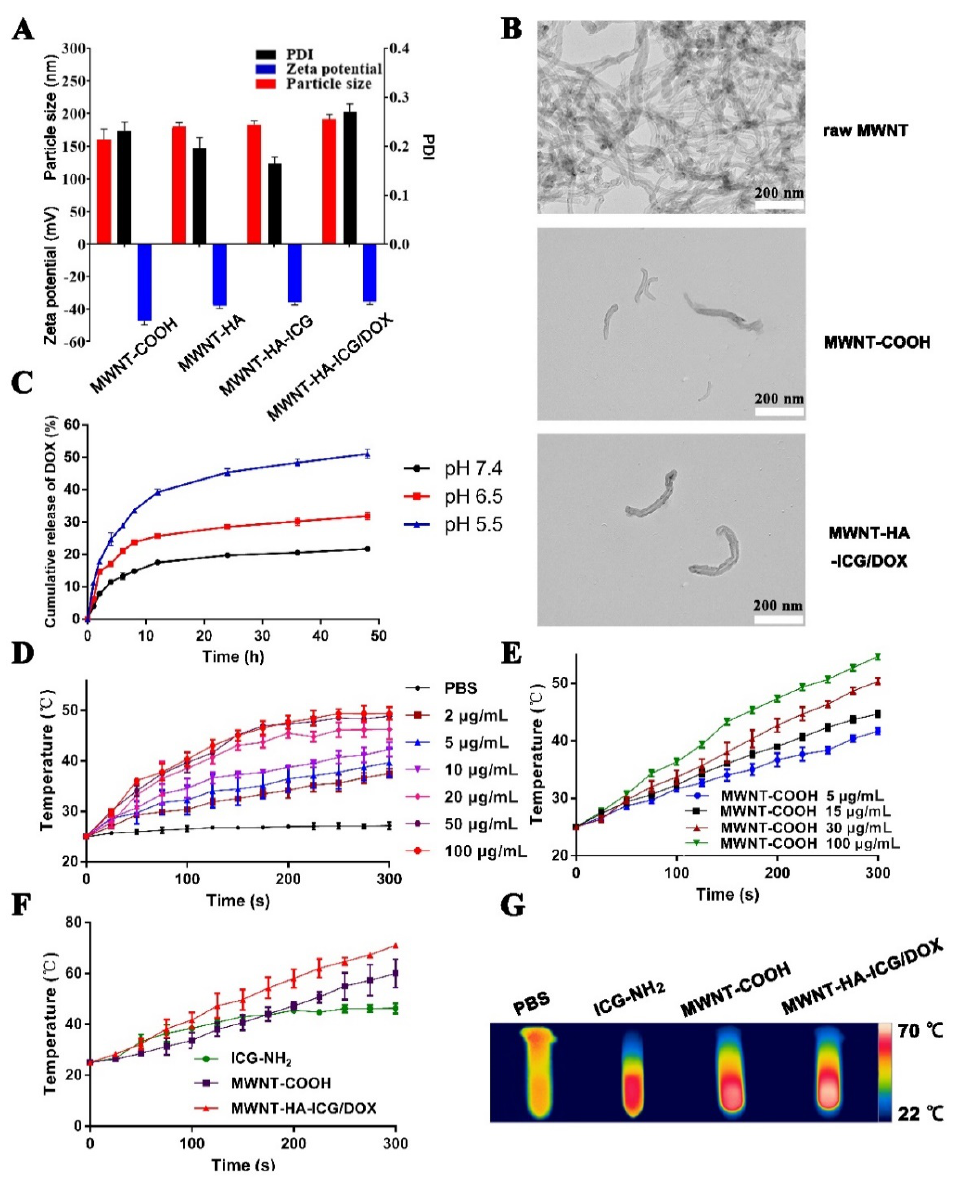
Figure 3. ( A ) Hydrodynamic diameter, zeta potential, and PDI of different MWNT-based formulations. ( B ) TEM images of raw MWNT, MWNT-COOH and MWNT-HA-ICG/DOX. ( C ) Cumulative release curves of DOX from MWNT-HA-ICG/DOX in three phosphate buffers with different pH. In vitro temperature curves of ( D ) free ICG-NH 2 , ( E ) MWNT-COOH at various concentrations, and ( F ) free ICG-NH 2 (20 µ g/mL), MWNT-COOH (100 µ g/mL) and MWNT-HA-ICG/DOX after laser irradiation for 5 min (808 nm, 1.0 W/cm 2 ). ( G ) Infrared thermographic maps of free ICG-NH 2 , MWNT-COOH, and MWNT-HA-ICG/DOX determined at 5 min after continuous laser irradiation.